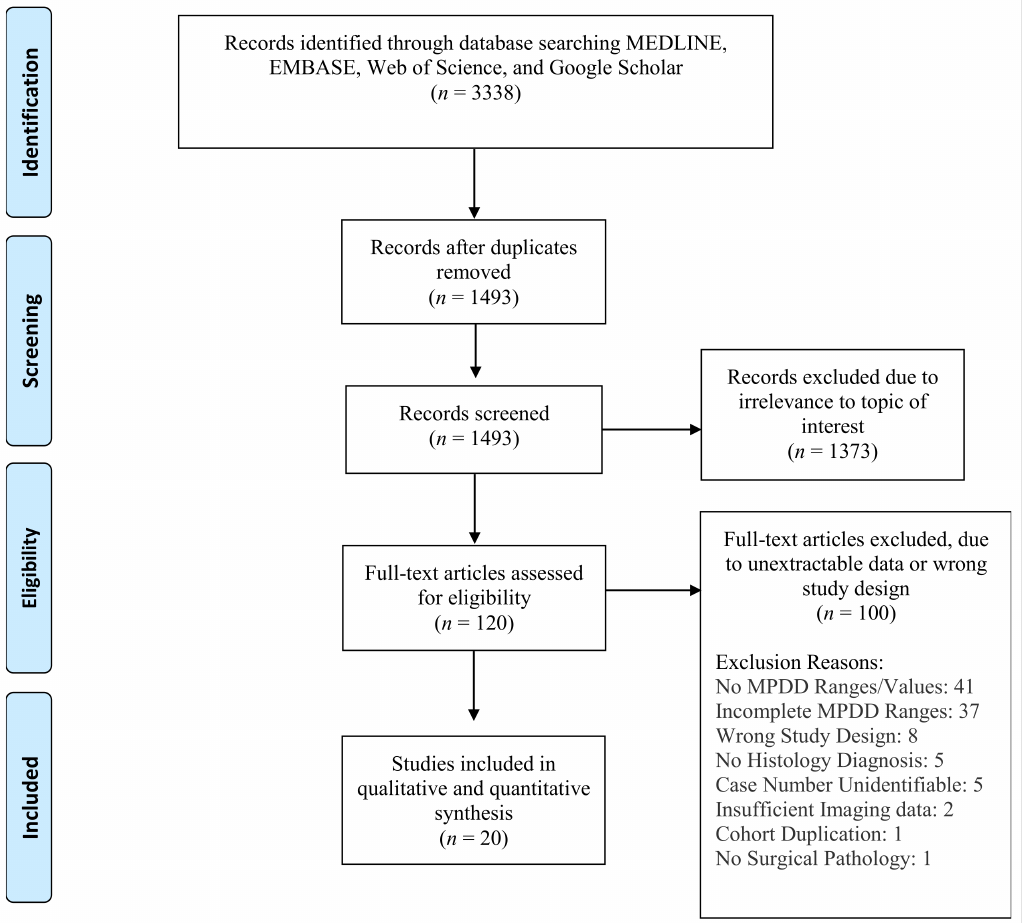
Figure 1. PRISMA flow chart showing the article selection